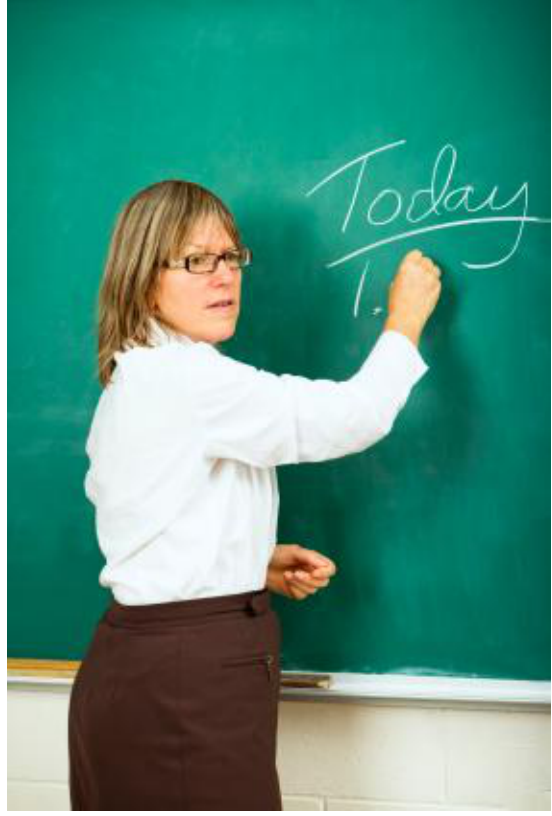
Figure 1. The model of a dowdy schoolteacher is often a conservatively styled in bland dress with